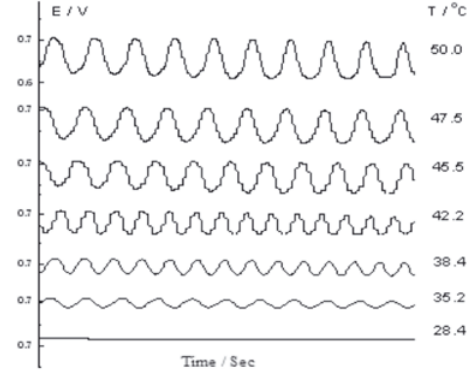
1. Time series profiles at different temperature. Common conditions: [MnSO [KBrO ]=1.75 × 10 -2 mol L -1 ,[Tartrate]=1.05 × 10 -2 mol L -1 , 3